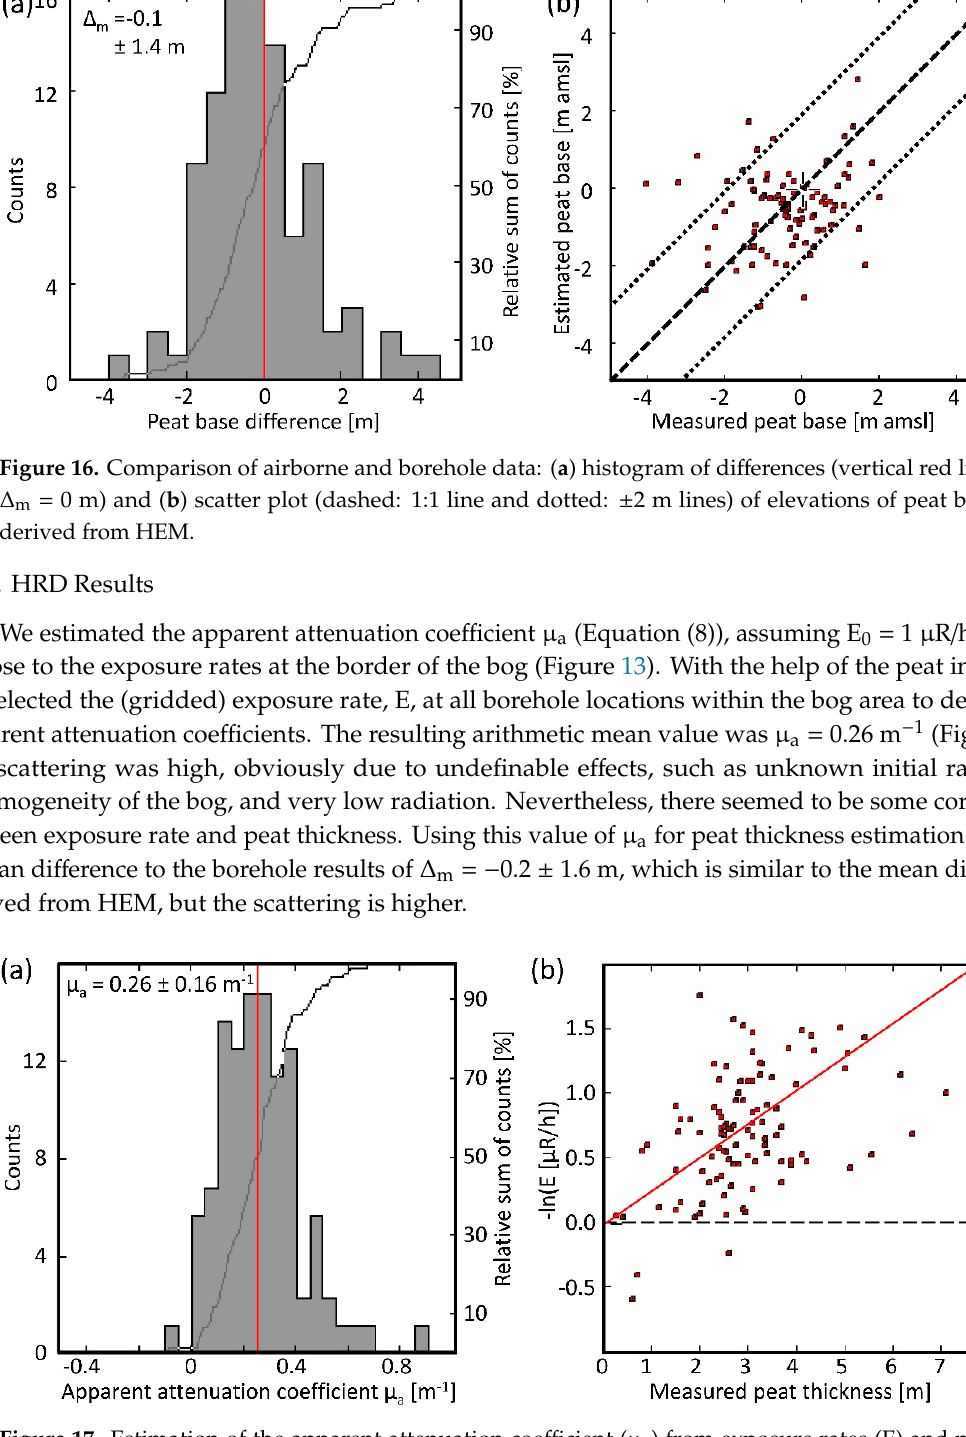
Figure 15. Vertical resistivity section along flight line L94.1 (above) derived from smooth inversion of HEM data, and peat elevations/thicknesses (below) derived from HEM or/and HRD data in comparison with peat ranges found in boreholes (brown columns). HEM_line: SG analysis along lines, HEM_Grid: gridded HEM results, HRD_Grid: gridded HRD results, HEM + HRD: combined results. Surface elevation and a peat indicator (derived from airborne data) are also shown.